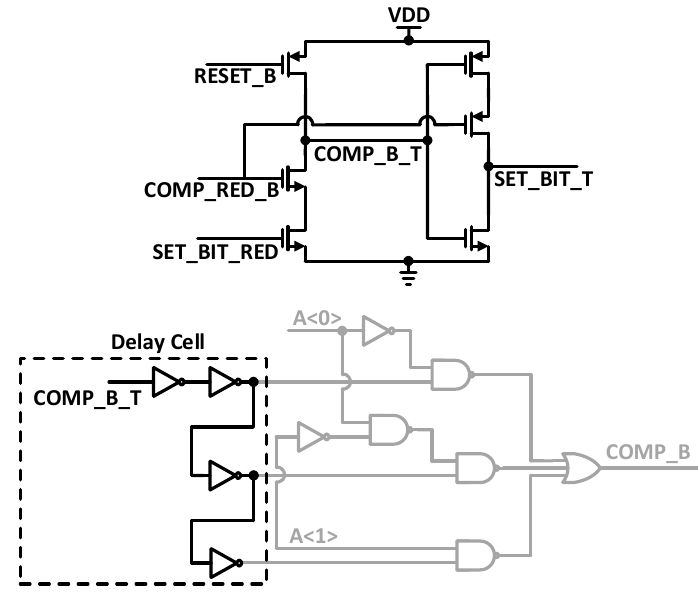
Figure 5. Main control block with DAC loop delay logic.